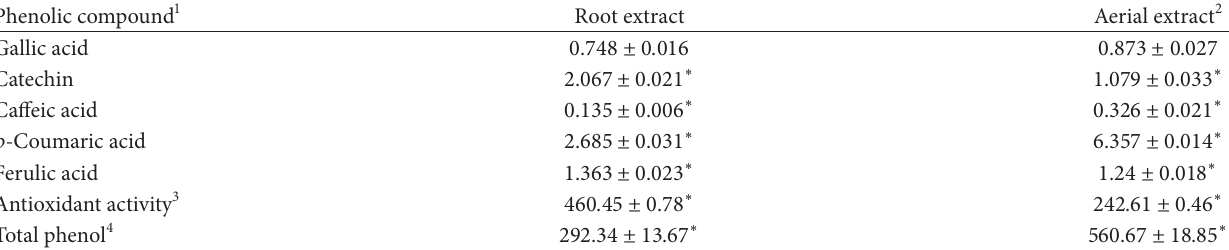
Table 2: Phenolic compounds and antioxidant activity of T. graminifolius ethanolic extract in root and aerial part determined by HPLC. Phenolic compound 1 Root